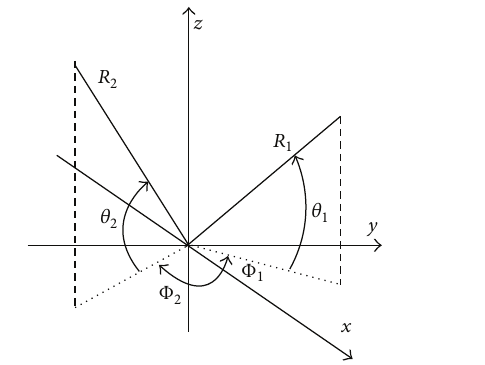
Figure 3: The angles for two directions 𝑅 1 and 𝑅 2 (the object is in the origin).